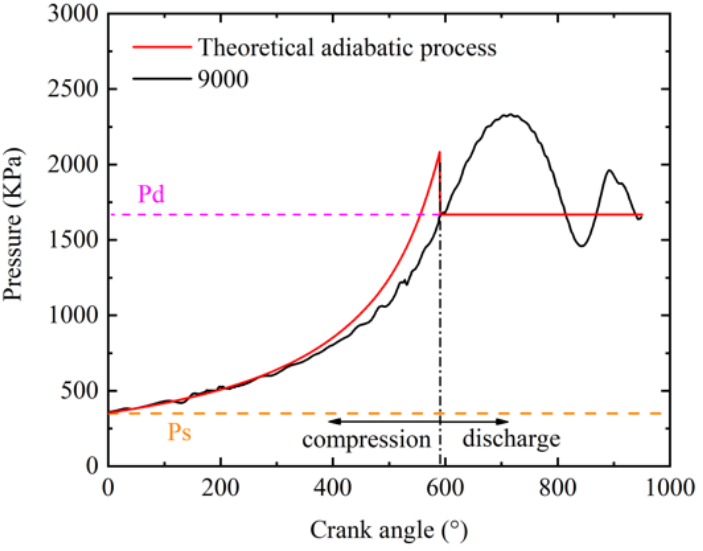
Figure 9. Comparison of the pressure change profiles with the crank angle between the theoretical adiabatic process and 3D transient simulation.